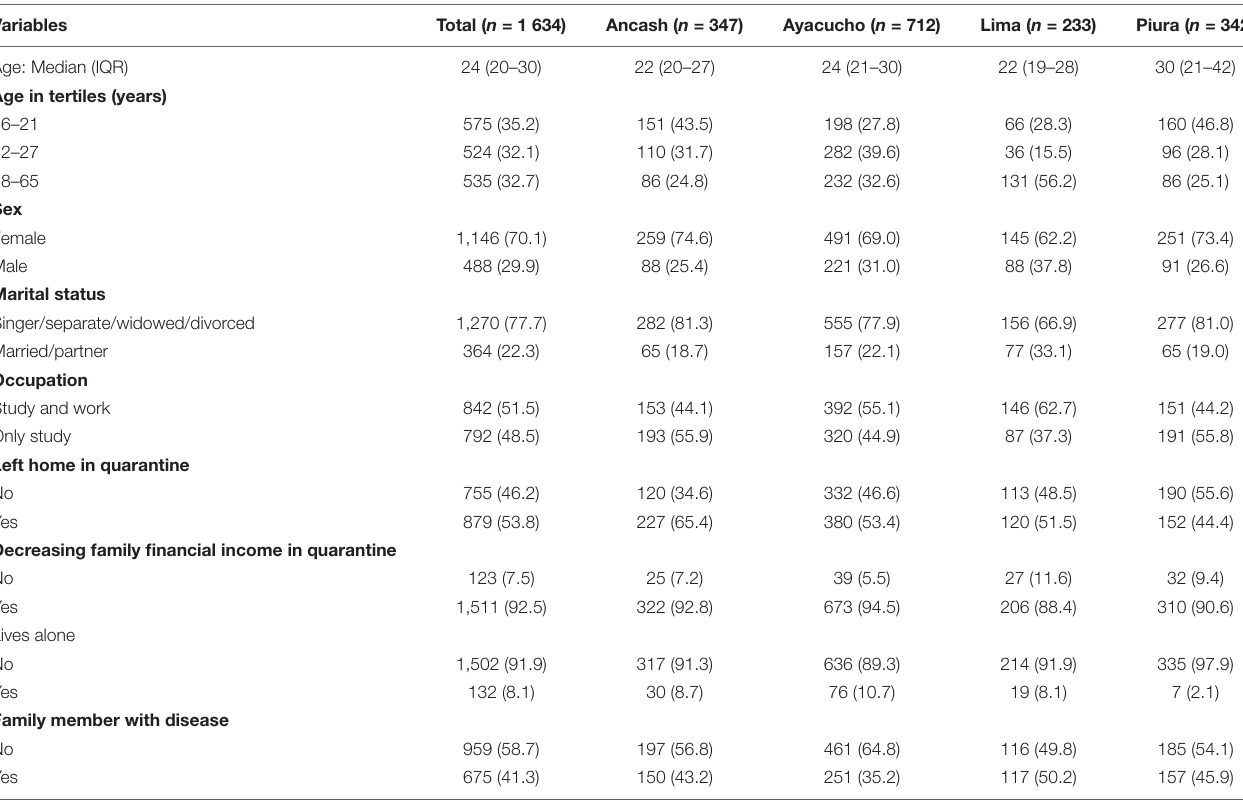
TABLE 1 | Characteristics of the populations